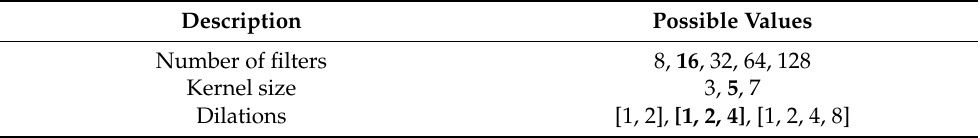
Table 3. Model hyperparameters that were optimized for, and the corresponding sets of possible